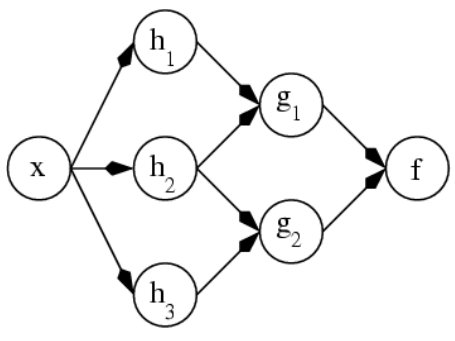
Figure 8. Feedforward artificial neural network [40].